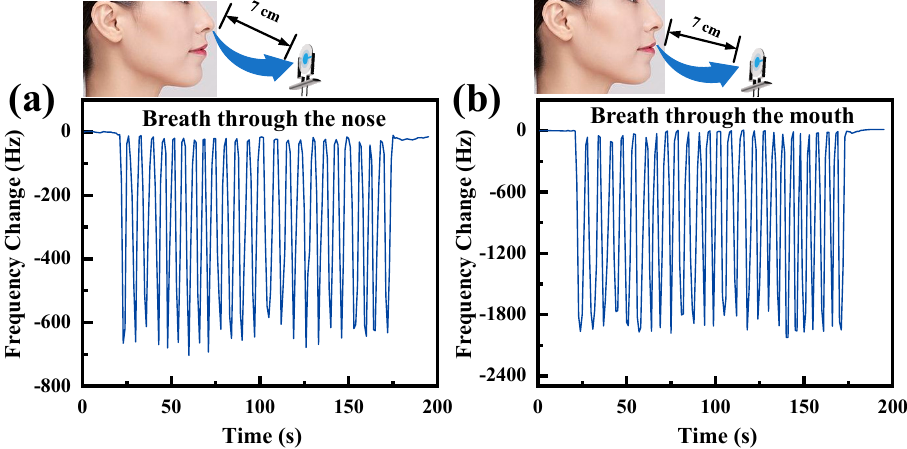
Figure 8. Human breathing monitoring with ChNF-integrated QCM sensors: ( a ) mouth breathing, ( b ) nose breathing.